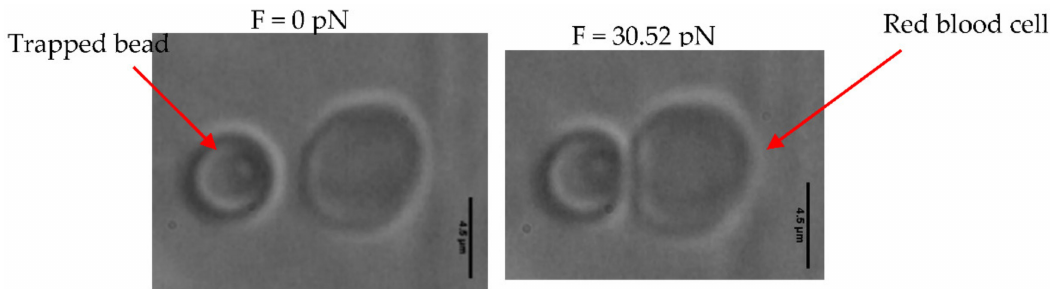
Figure 3. Images of the silica bead interacting with the biconcave RBC in PBS solution with an osmolarity of 300 mOsm. Ten biconcave RBCs were used. The scale bar represents 4.5 µ m.